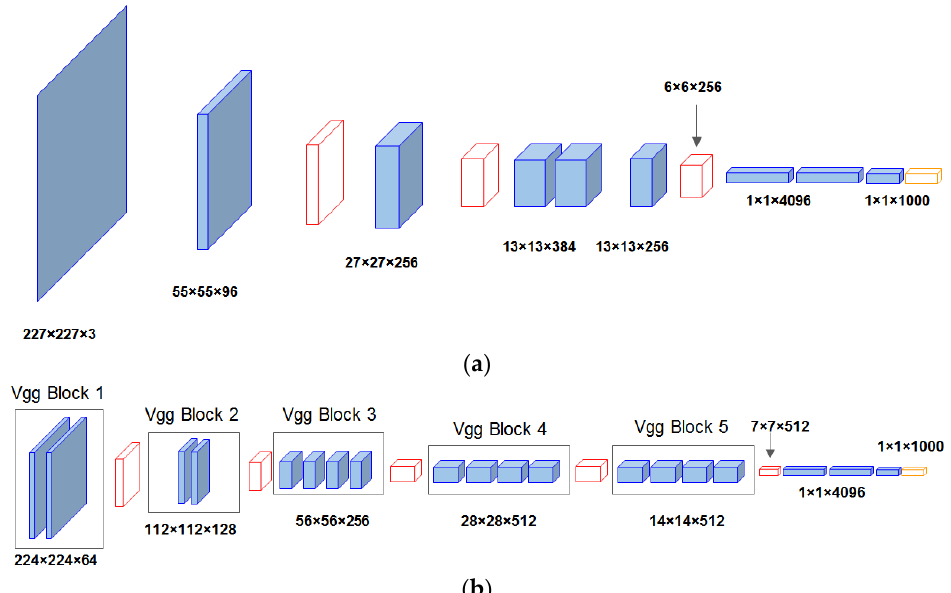
Figure 5. Schematic diagram of ( a ) AlexNet and ( b ) VGG19